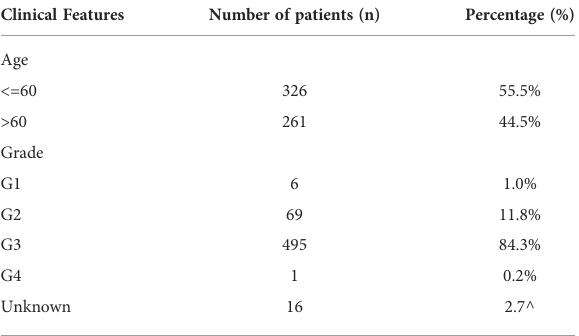
TABLE 1 Basic information of enrolled patients. Clinical